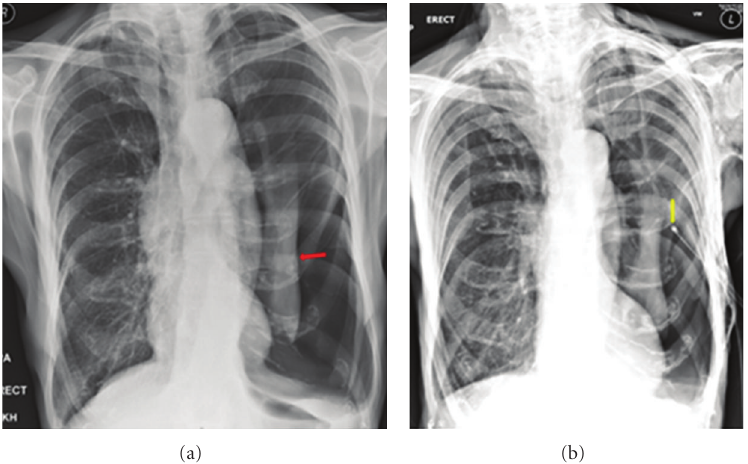
Figure 26: Reexpansion pulmonary edema (REPE) is a rare complication occurring after the insertion of a chest tube for pneumothorax or pleural e ff usion. REPE can appear on the ipsi- or contralateral side, can be bilateral and can even be asymptomatic. The case illustrated developed an ipsilateral REPE over a period of 6 hours following placement of a chest drain for a pneumothorax. The patient stabilized under continuous oxygen (12L/min via a nonrebreather facemask) with his oxygen saturation steadily increasing. The patient required no further treatment. REPE is a serious complication associated with mortality of approximately 20%. Also, see Figure